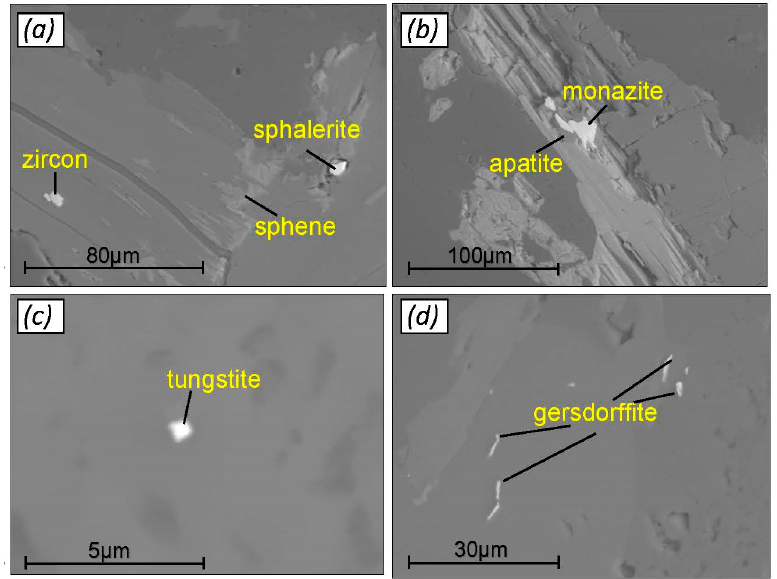
Figure 6. Micrometer accessory minerals in Na-granite (samples TO-4 and TO-10). ( a ) Zircon (spectrum 1) and sphalerite (spectrum 2) in a matrix defect; ( b ) nests of monazite in apatite; ( c ) tungstite; ( d ) gersdorffite streaks.